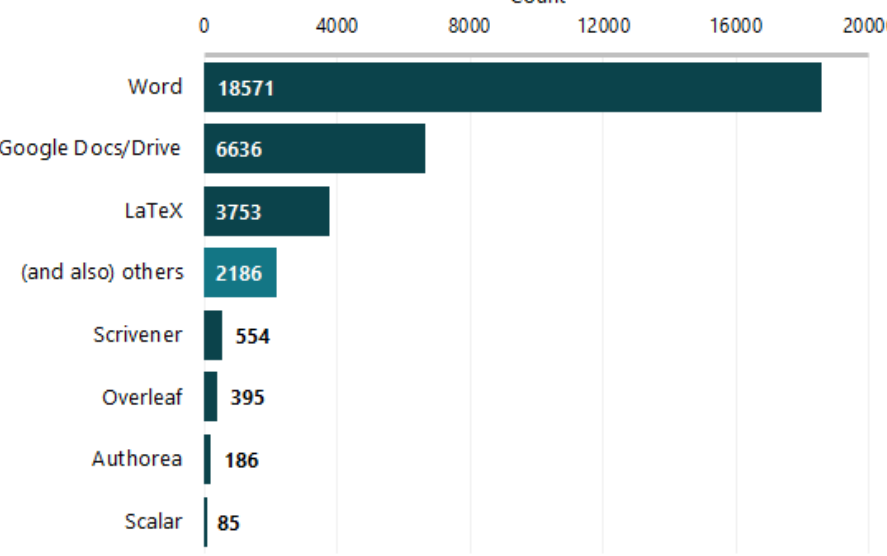
Figure 6: Fragment from the survey results demonstrating the tools for the Writing stage (source: https://101innovations.wordpress.com/survey-results/research-activities/write/).